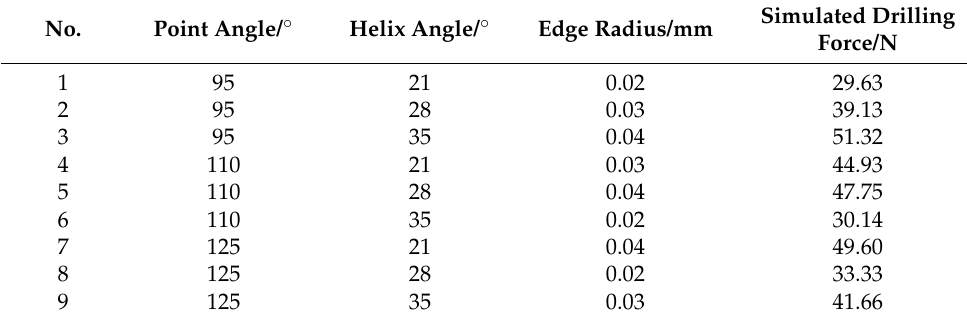
Table 4. Orthogonal arrays for three process parameters.